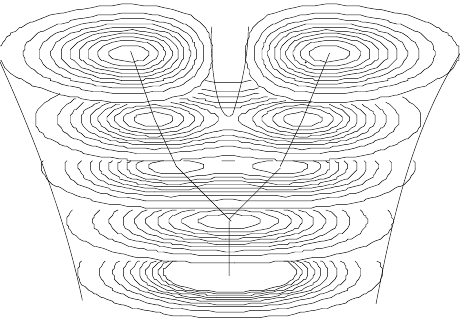
Figure 7. Model of branching and bifurcation. Successive solutions of the time-dependent 2D Schr ¨ odinger equation in an harmonic oscillator potential are plotted as isodensities. The energy varies from the fundamental level ( n = 0 ) to the first excited level ( n = 1 ), and, as a consequence, the system jumps from a one-structure to a two-structure